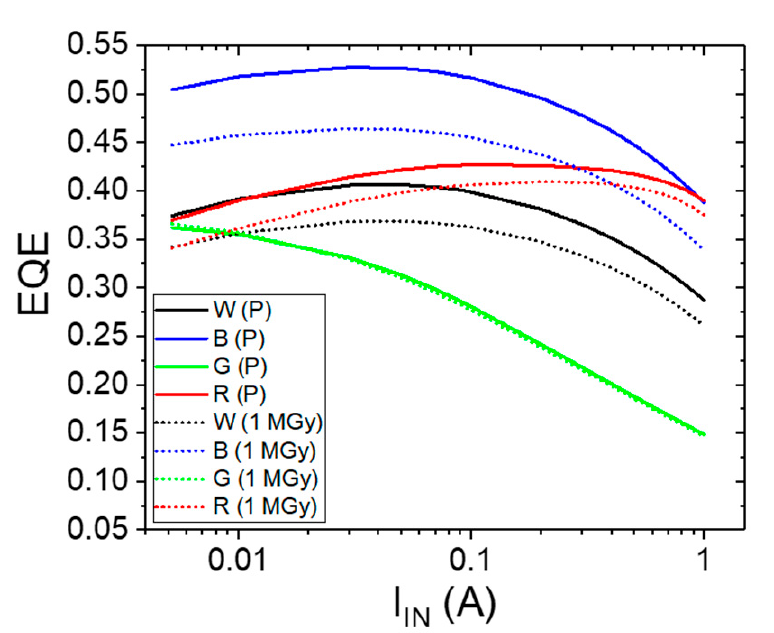
Figure 7. EQE vs. current example for our P3 sample (pristine (P) and after 1 MGy of absorbed dose). A 0.1 A drive current was applied to each of this sample of four diodes during the whole irradiation run.